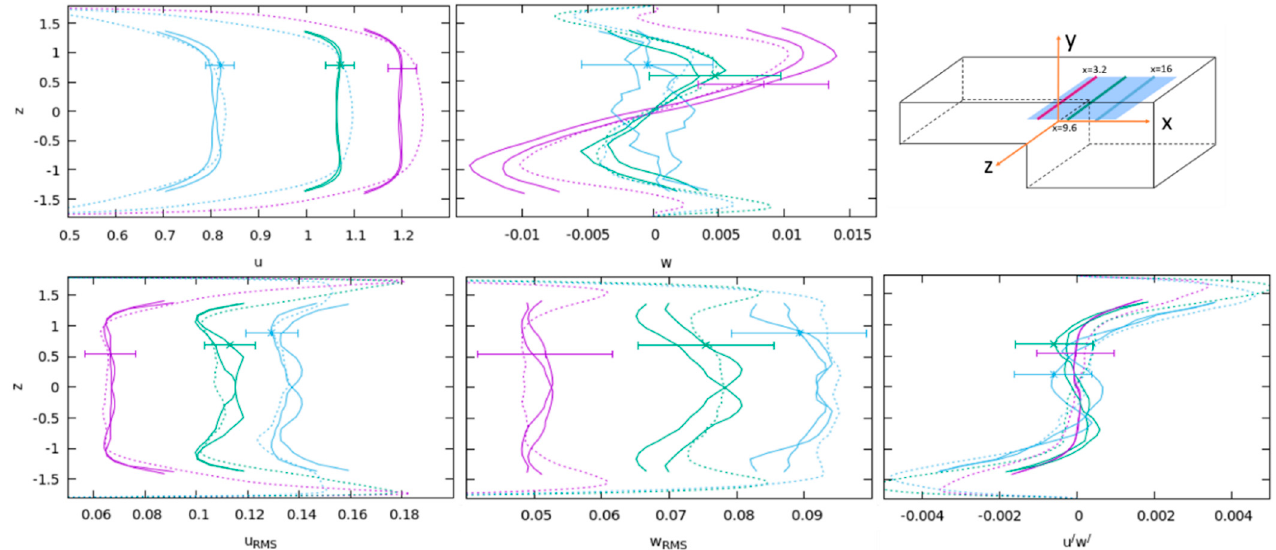
Figure 10. Measurement ‘y+0.8’, profiles at x = 3.2, 9.6, 16. Variables: u, w, u RMS , w RMS , and u ′ w ′ . Solid lines: original measurements and measurements mirrored over z = 0. DNS—dotted lines. Uncertainties are given in a single point per profile.